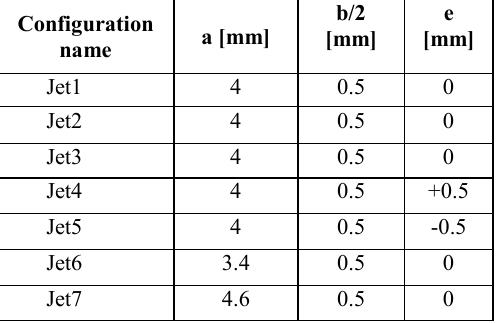
Table 1. Double slot jet configurations - dimensions Configuration